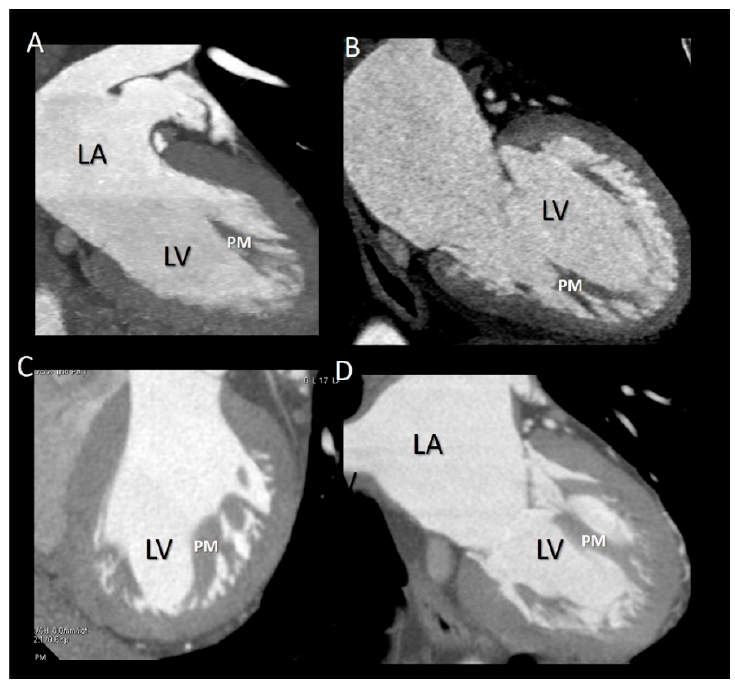
Figure 9. ( A–D ) CT representative images showing as the base of PMs do not attach to the compact